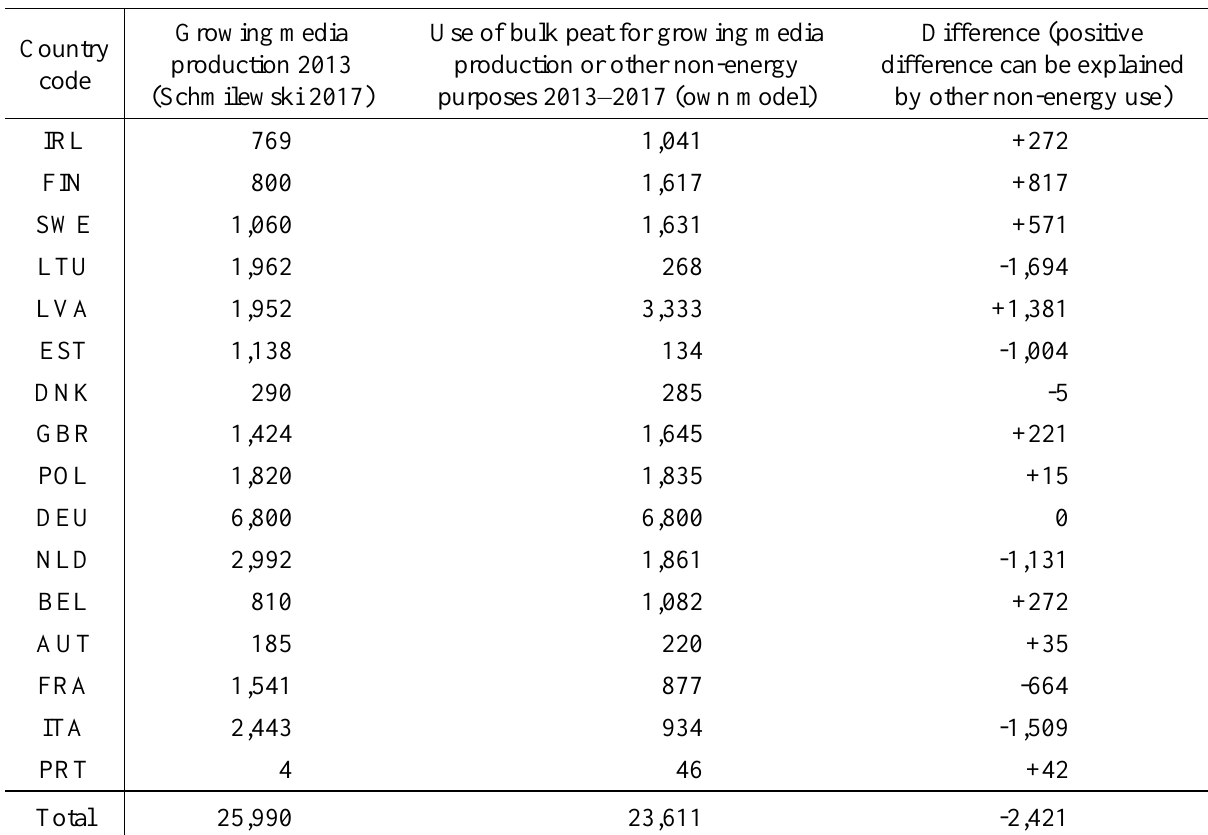
Table 2. Difference between data on growing media production and differentiated results of the modelling process. Unit: 1,000